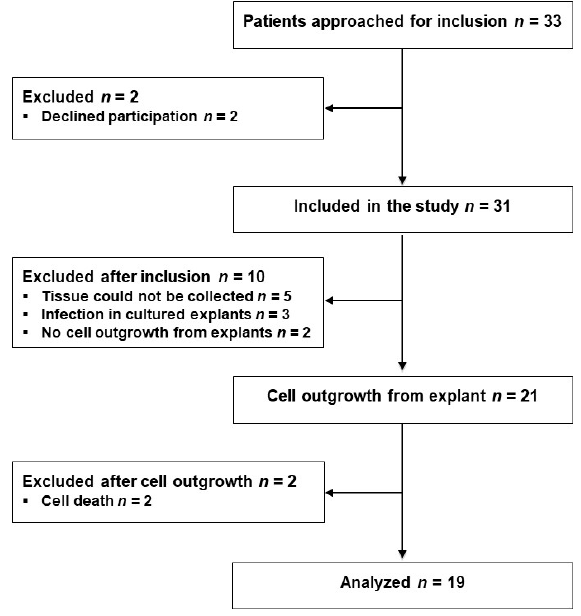
Figure 1. Flow diagram of the study participants.